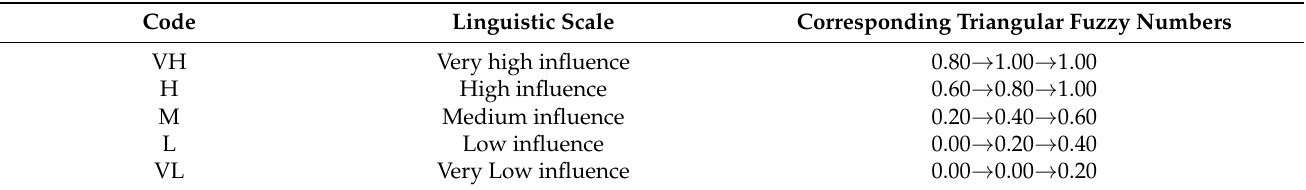
Table 3. Fuzzy TOPSIS Linguistic